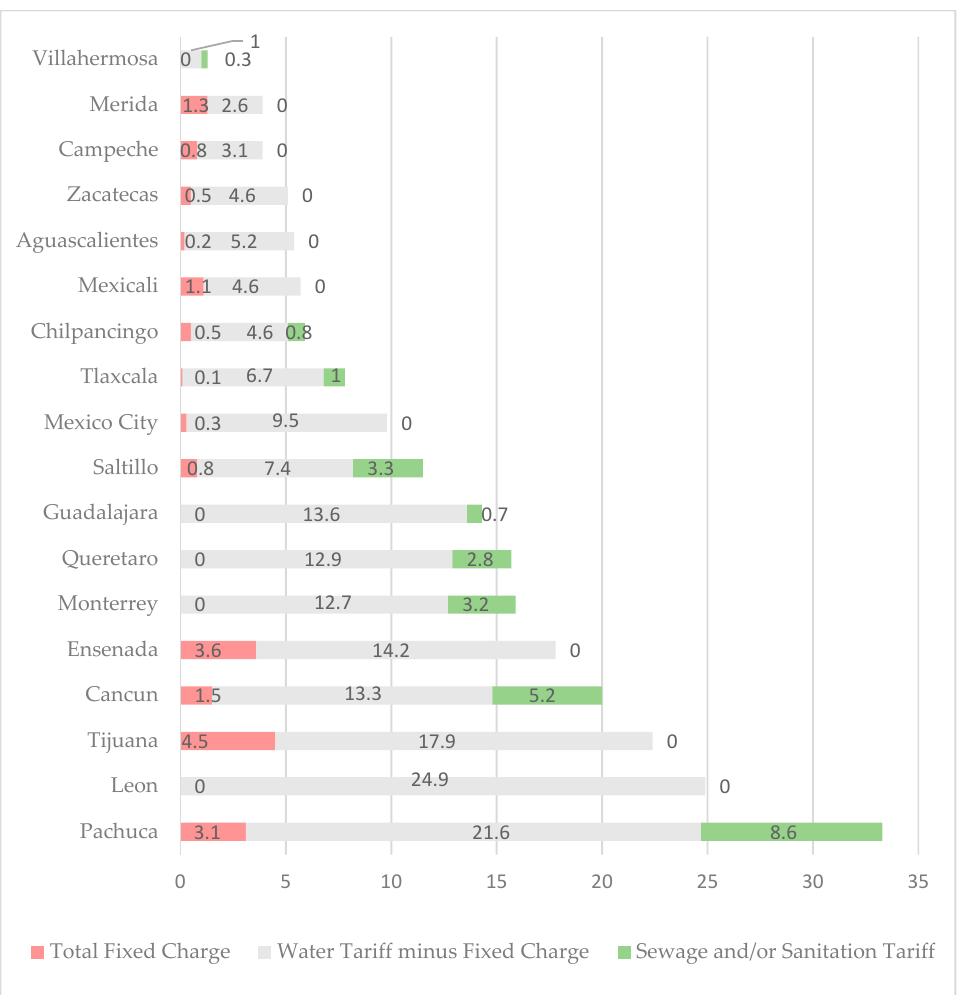
Figure 3. Drinking-water and sanitation tariffs for domestic use of popular type (or equivalent) in selected cities in Mexico, 2016 ($MX per cubic meter). Source: Authors’ elaboration with data from CONAGUA [23]; Note: Tariffs for a consumption of m 3 per month.